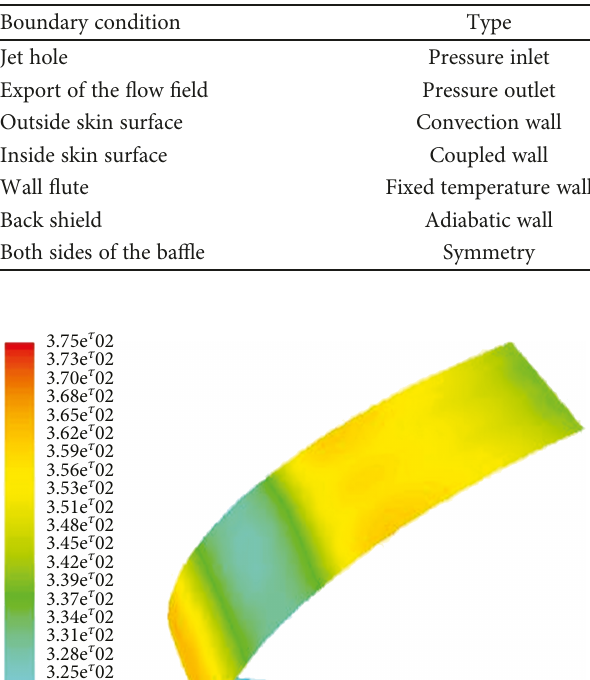
Table 1: Boundary condition